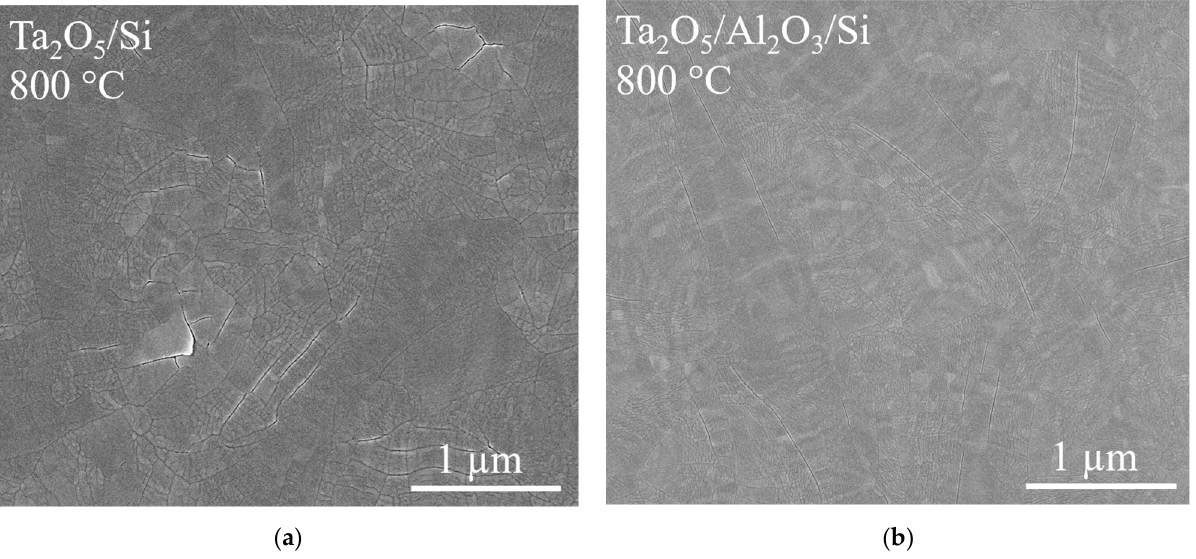
Figure 6. SEM images of the surface of laminates after annealing at 800 °C: ( a ) Ta 2 O 5 /Si; ( b ) Ta 2 O 5 /Al 2 O 3 /Si.